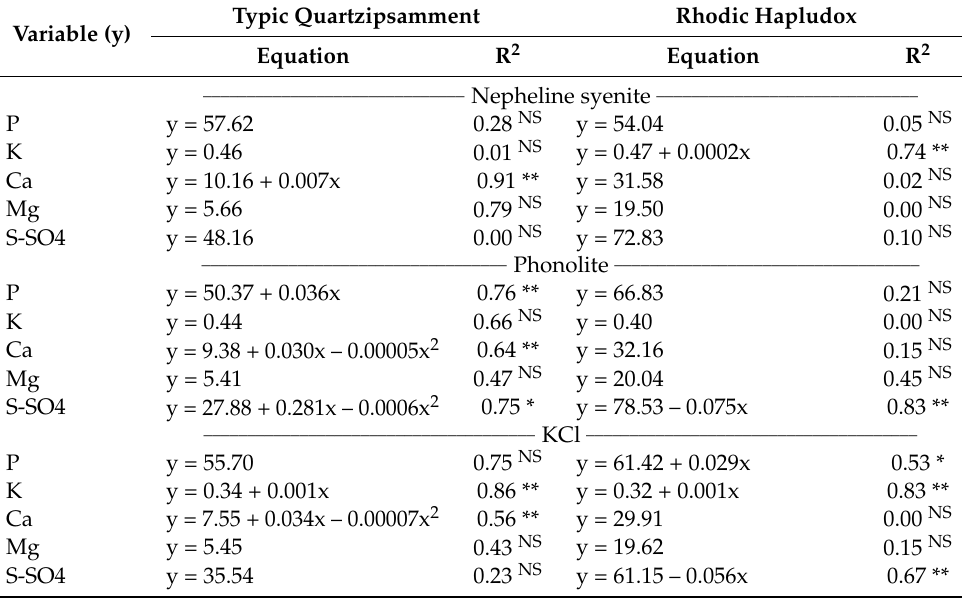
Table 8. Coefficients of determination (R 2 ) and regression equations that best fit the relationships between macronutrient levels in soils after maize cultivation as a function of K